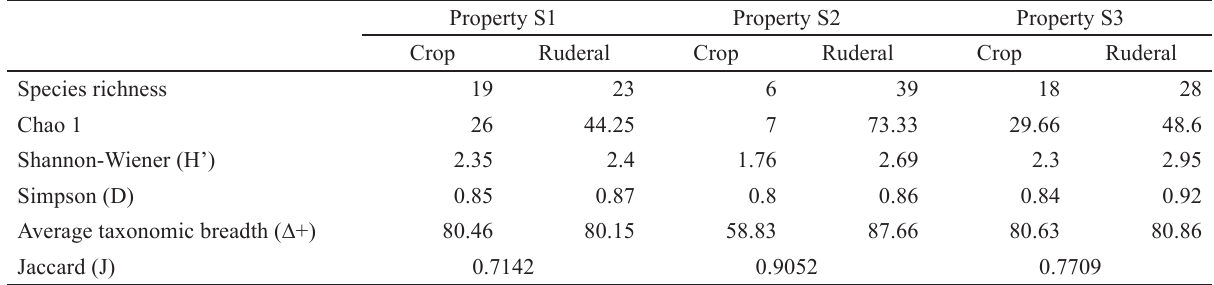
Table 4 . Richness estimators, diversity and dominance indexes for bees sampled from crop and ruderal plants at three smallholder rural properties in Guapiara, São Paulo state, Brazil, between May 2012 and March